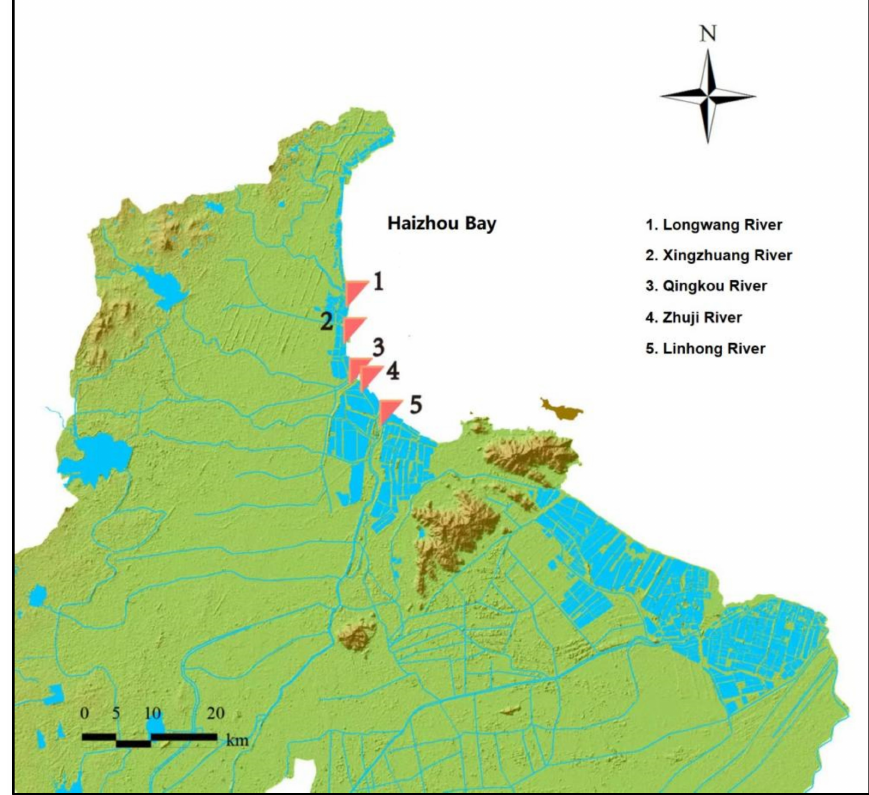
Figure 4. Distribution of main marine estuaries in Haizhou